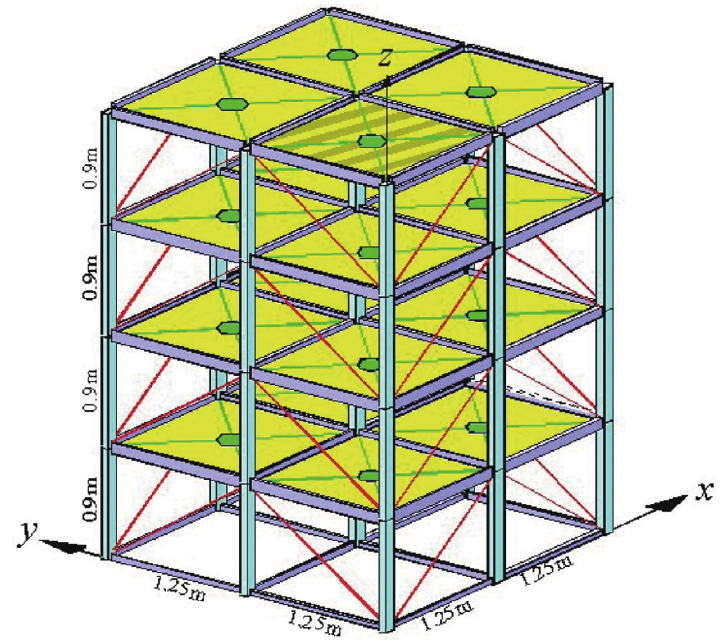
Fig. 3. Geometry of the benchmark structure